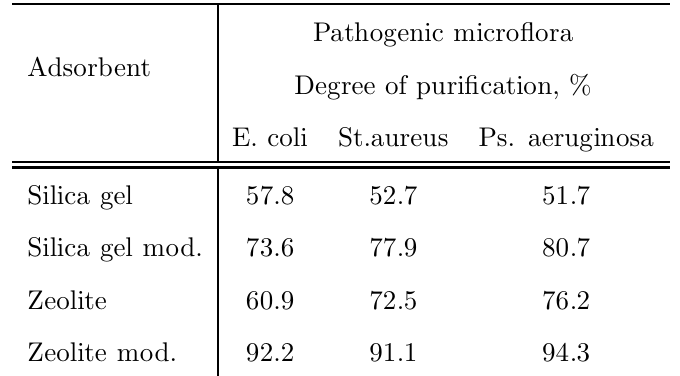
Table 8 The in®uence of modi› cation of natural sorbents on the degree of water puri› cation from pathogenic micro®ora